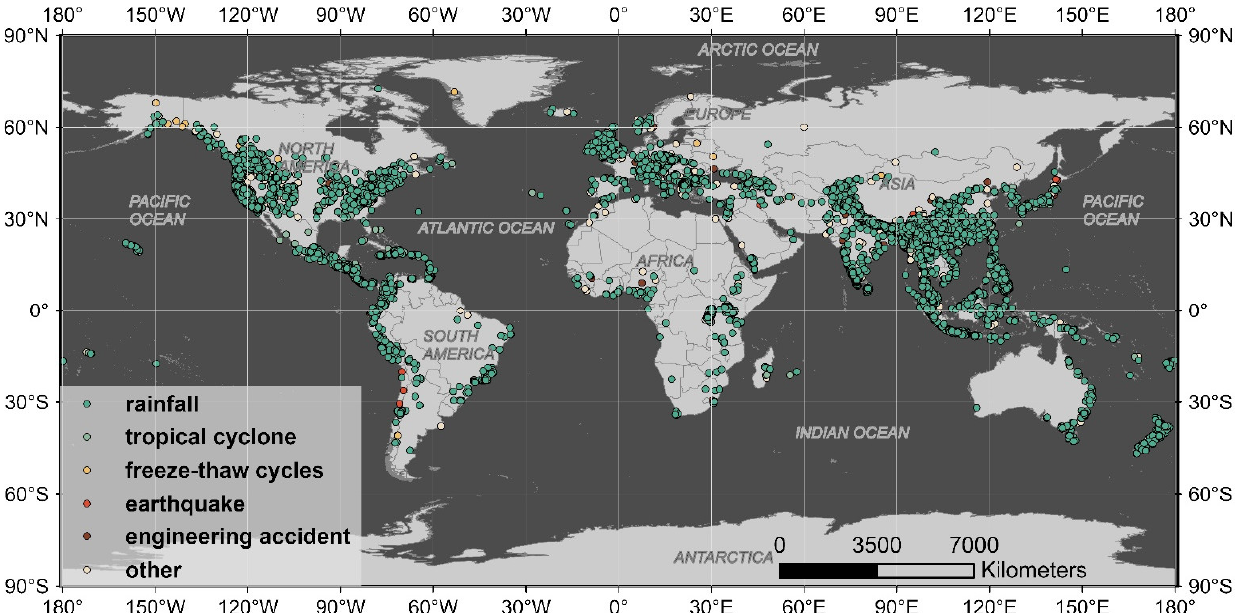
Figure 1. Spatial distribution of landslide events with different triggering factors. The landslide data source is COOLR.